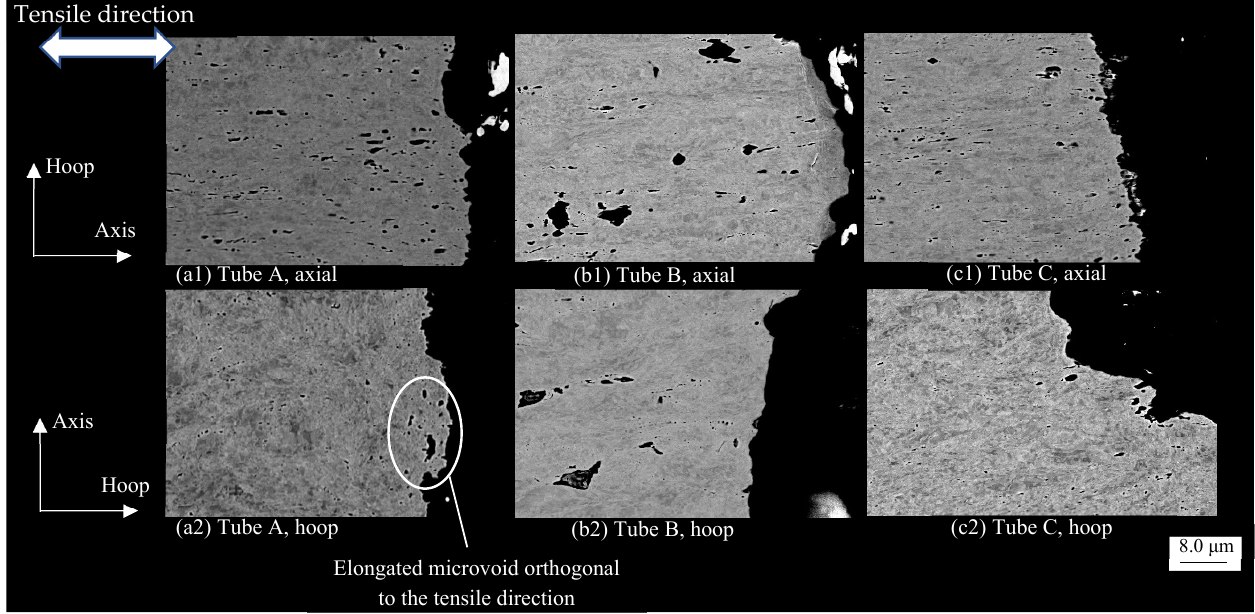
Figure 12. SEM images of the tensile specimen cross-section around the fracture surface.